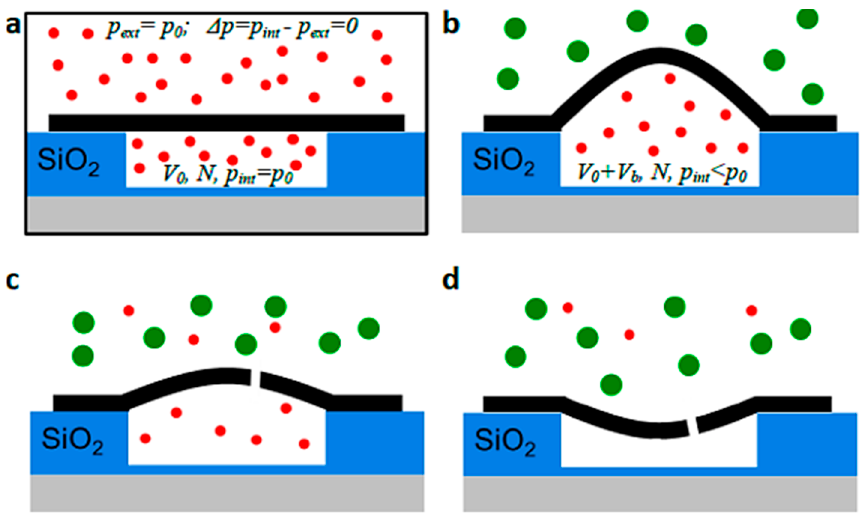
Figure 4. Measuring leak rates in porous graphene membranes: ( a ) schematic of microscopic graphene membrane on silicon oxide substrate; ( b ) after removing graphene membrane from pressure chamber, the membrane is bulged upward; ( c ) upon etching of graphene membrane, pore(s) bigger than that of H 2 are introduced allowing H 2 to leak rapidly out of microchamber through graphene membrane; and ( d ) after all H 2 molecules have leaked out of microchamber, the membrane will be bulged downward [94]. Red spheres = small H 2 molecules; green spheres = larger CO 2 gas molecules. Reproduced with permission from Nature.